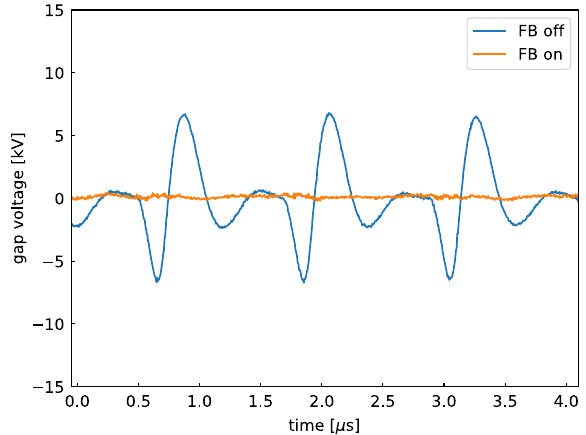
FIG. 32. Comparison of the gap voltage waveforms in the case of acceleration of a single bunch without and with feedback just before extraction at 19.9 ms.